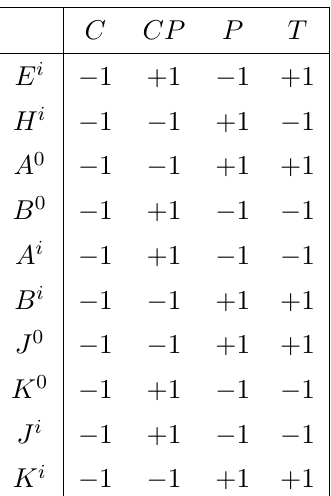
Table 1 . Discrete symmetry transformations of electromagnetic fields, potentials, and